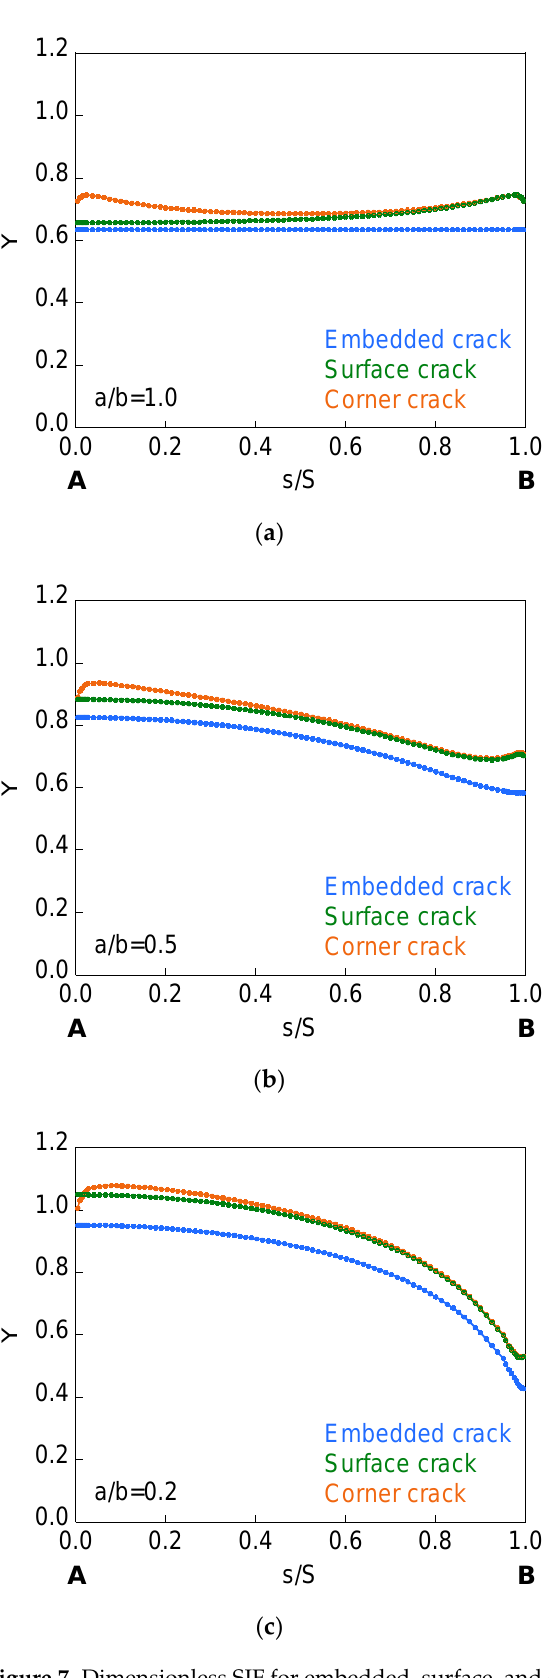
Figure 7. Dimensionless SIF for embedded, surface, and corner cracks in an infinite-thickness plate for ( a ) a / b = 1.0, ( b ) a / b = 0.5, and ( c ) a / b = 0.2.